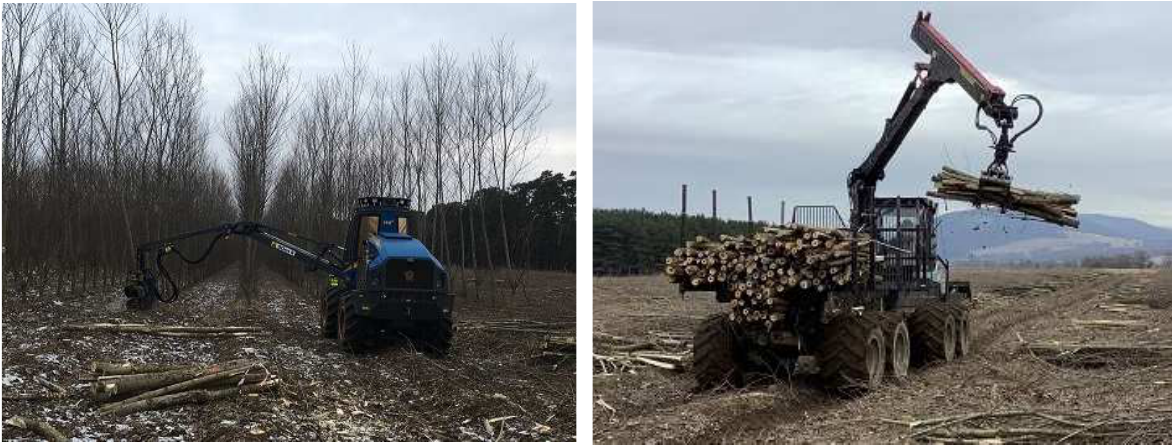
Figure 1. The harvester ( left ) and the forwarder ( right ) used for the experiment.